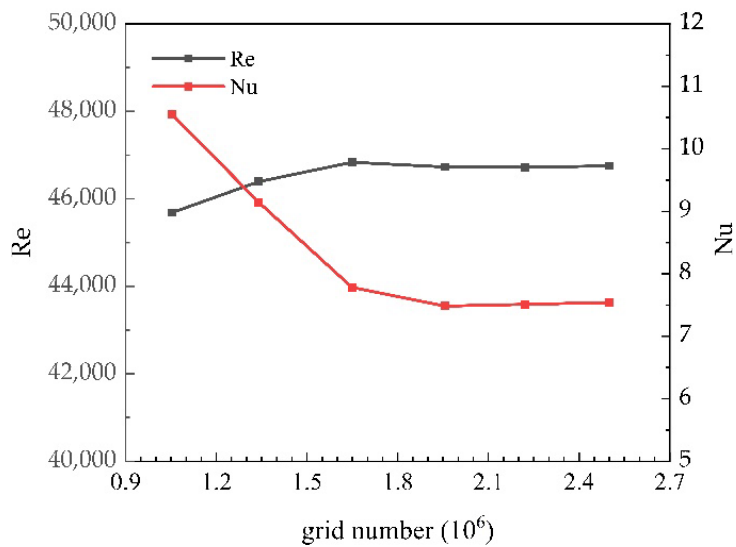
Figure 8. Value of Nu and Re for different grid generations.